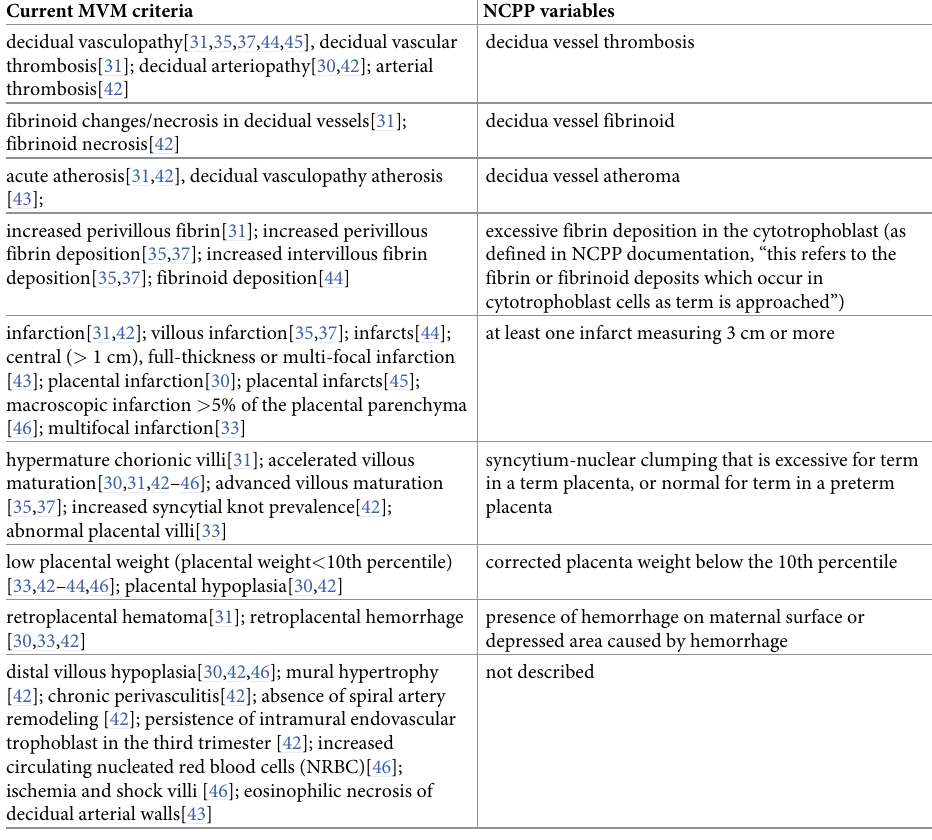
Table 1. Comparison of lesions currently used to define MVM and variables available in NCPP